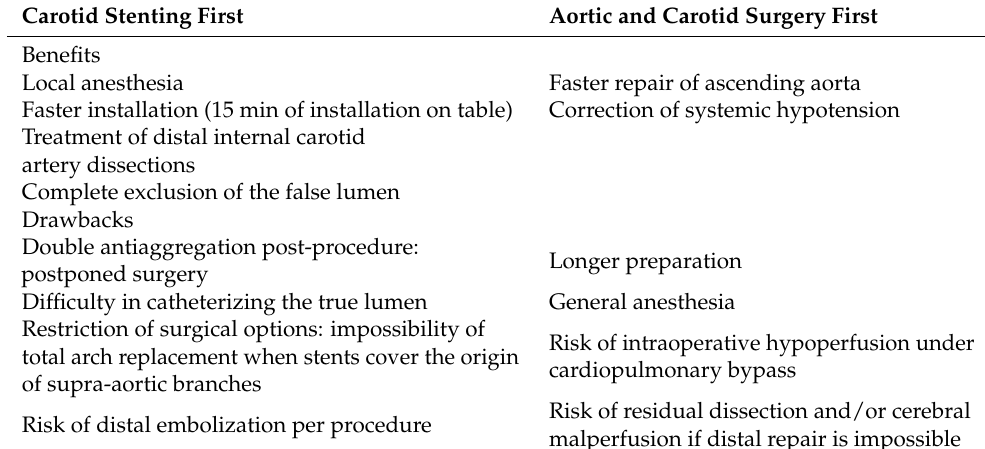
Table 3. Comparison of benefits and